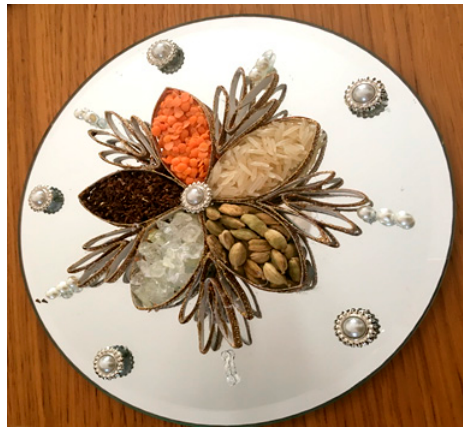
Figure 2. Also referred to as seniyyet bakht (tray of luck) taken by Shanneik 2017 in London. It is believed that this incense offers protection from the evil eye to prevent jealousy and envy.